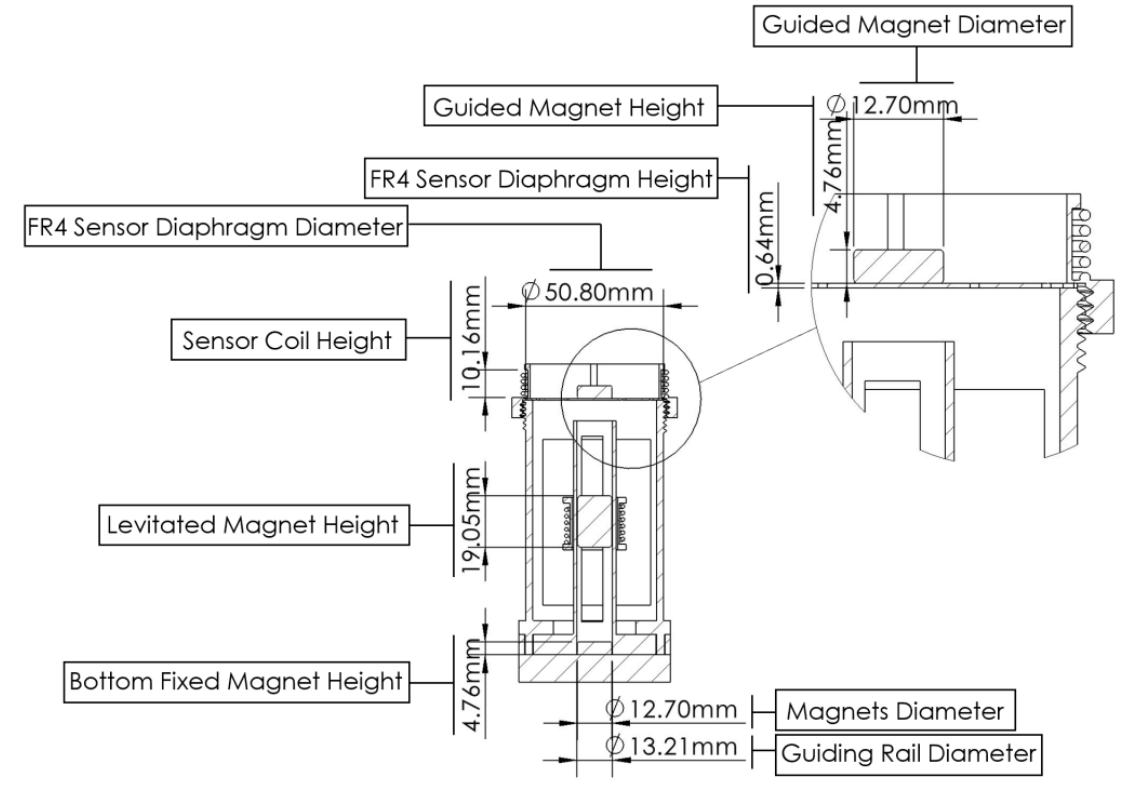
Figure 5. Cross-section view of the vibration energy harvester-sensor unit along with a blow-up detailed section view.